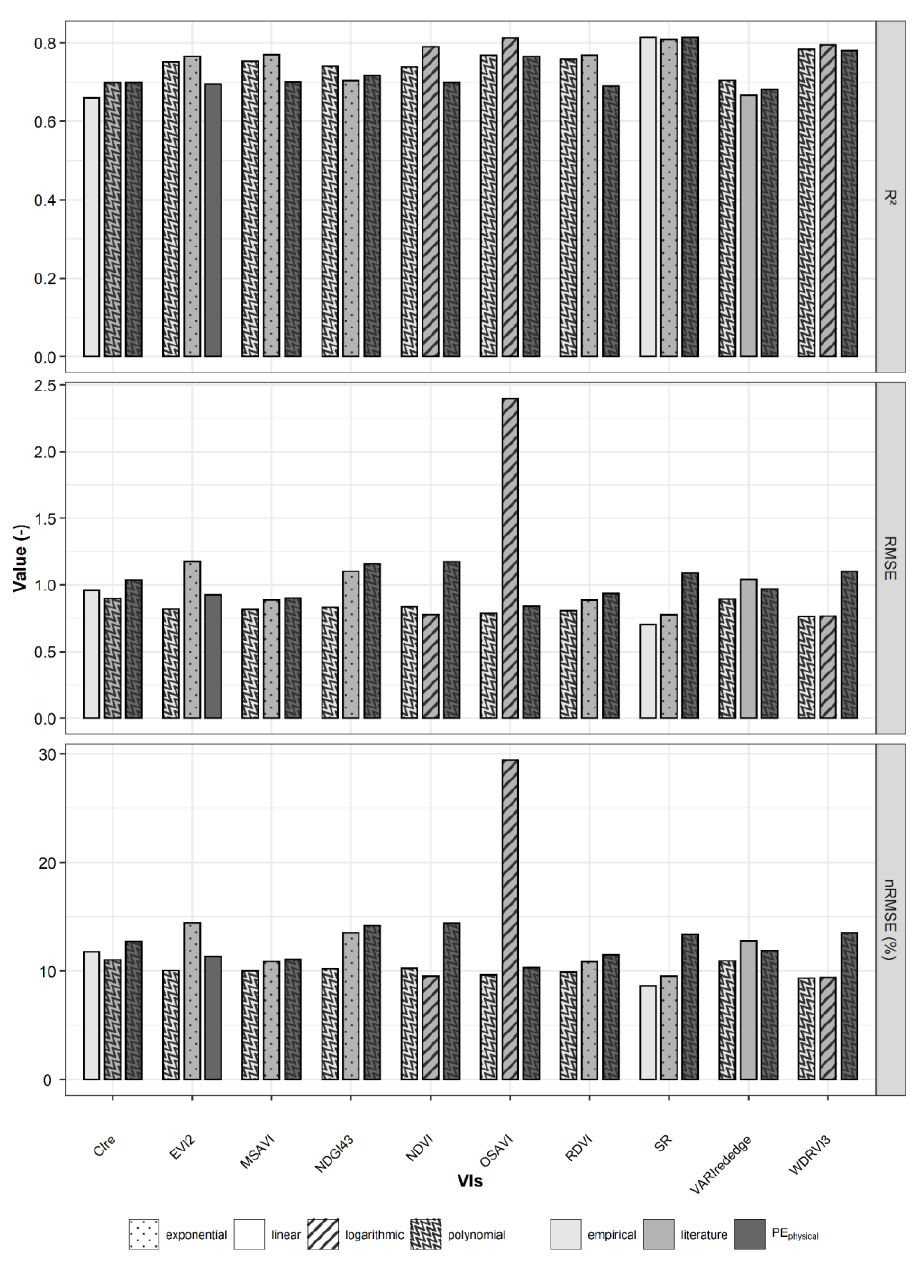
Figure 5. R 2 , RMSE and nRMSE (%) obtained between field measured and retrieved LAI from empirical, empirical literature models compared to PE physical